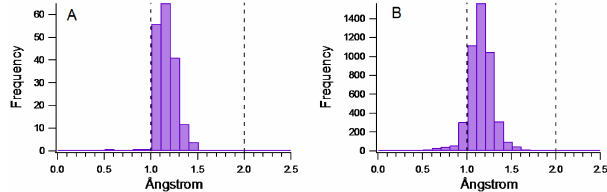
Figure 15. Histogram of hourly of Ångstrom coefficient for BT tower for (a) all de-coupling periods and (b) for the other